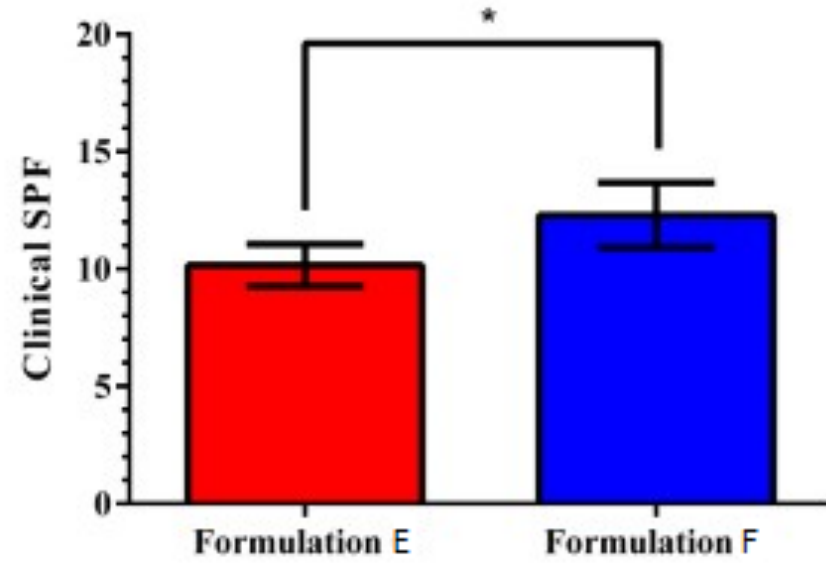
Figure 10. Photoprotective efficacy of formulations ( E ) — Base + UV filters: butylmethoxydibenzoyl methane, ethylhexyl methoxycinnamate and ethylhexyl dimethyl PABA; ( F ) — Base, UV filters and grape pomace extract ( V. vinifera L.). Paired Student’s t -test ( n = 10): p -value, 0.002 * = significant.